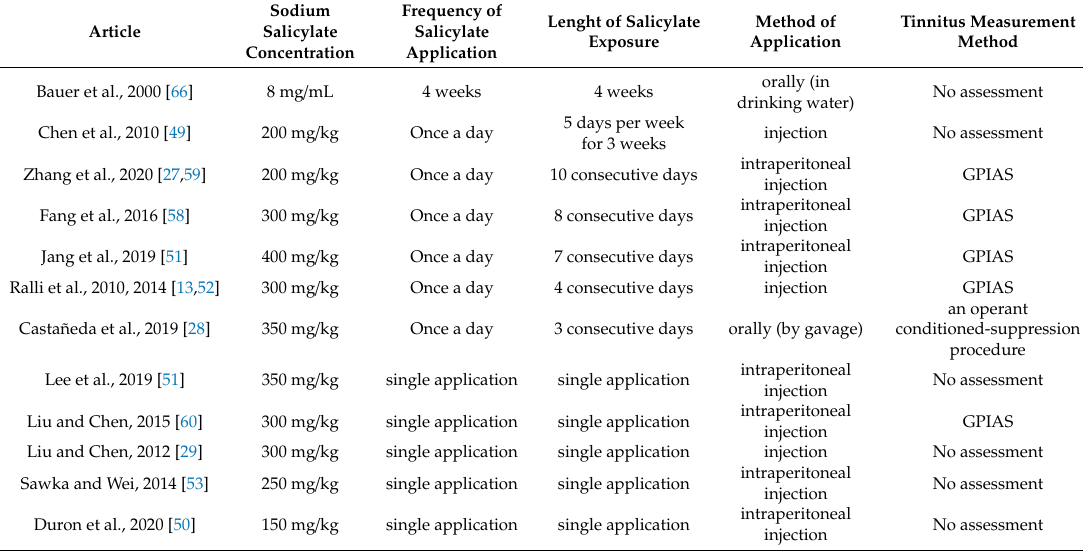
Table 2. Features of experiments with salicylate-induced